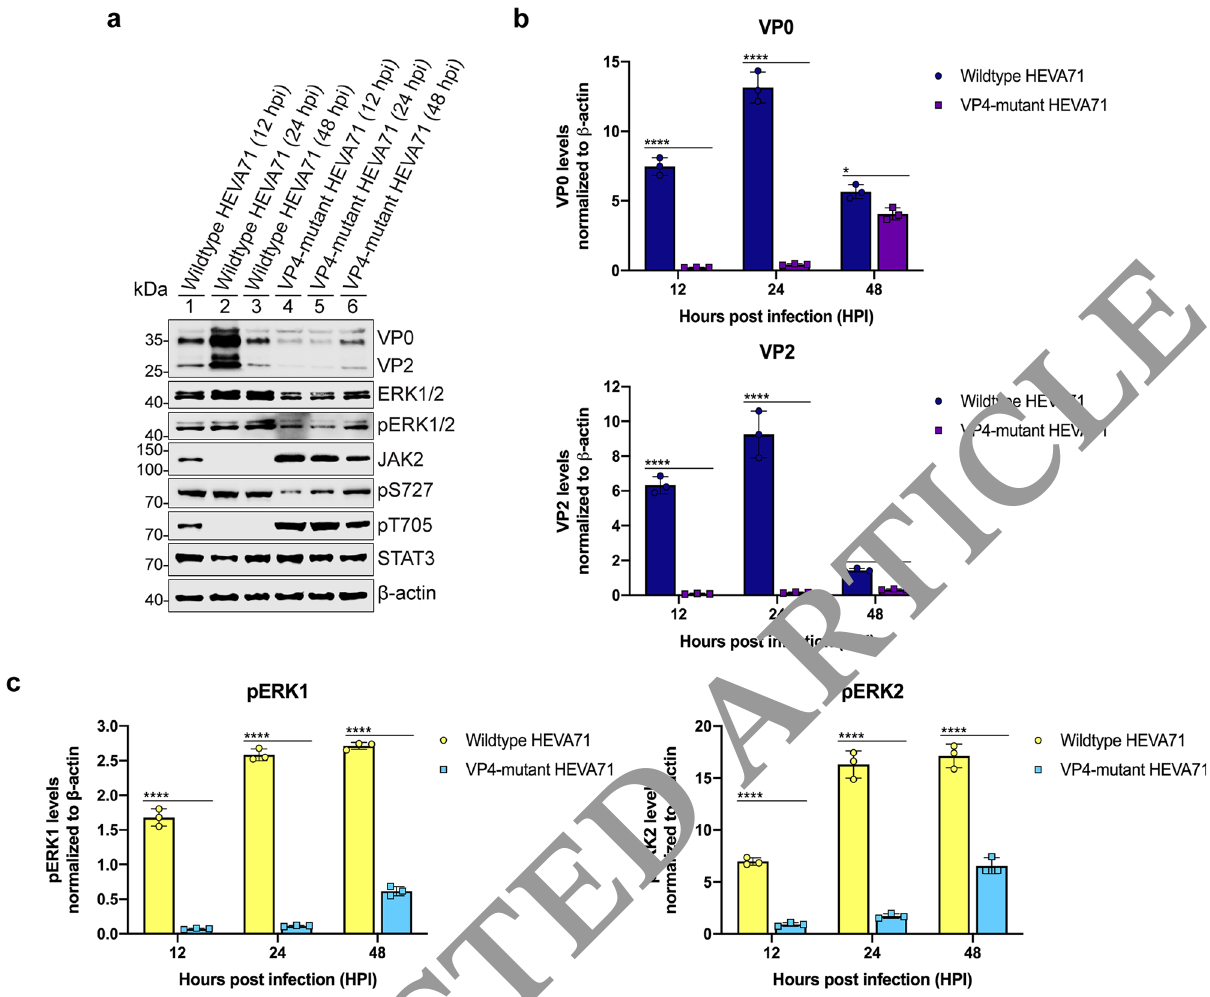
Fig. 8 VP4-mutant HEVA71 reduces CXCL1 signaling and subsequent HEVA71 replication in neuronal cultures. a Immunoblots of cell lysates from wildtype HEVA71 and VP4-mutant HEVA71-infected DIV7 neuronal cultures at 12, 24 and 48 hpi. Similar primary antibodies excluding caspase 3 were used. VP4 mutation delays the expression of HEVA71 viral proteins. Immunoblot representative of 3 biological repeats is shown. Bar charts below show quanti fi cations for each protein. b VP0 and VP2 levels decreased at all time points in neurons infected with VP4-mutant HEVA71. Exact P values for: VP0 at 48 hpi = 0.018 and VP2 at 48 hpi = 0.0161. c pERK1/2 levels were decreased in VP4-mutant HEVA71-infected neurons. Data are expressed as the average with error bars representing ±SD from 3 independent experiments ( n = 3). Statistical analyses were performed with two-way ANOVA corrected